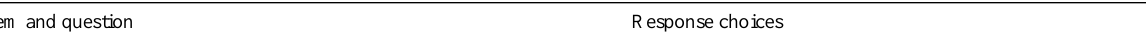
ScoreResponse choicesItem and question